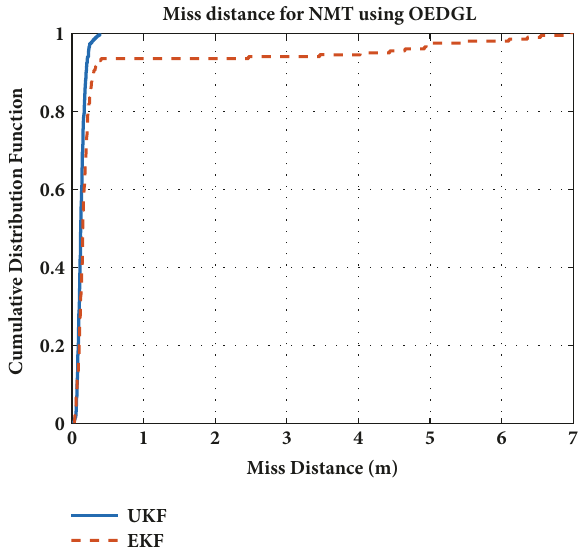
Figure 15: Miss distance CDF for